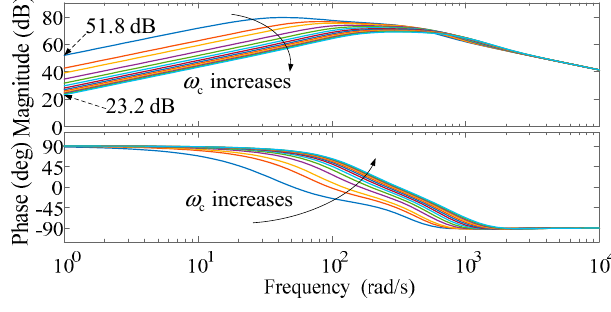
( s ) with changing ω c (di ff erent colors represent di ff erent gains; the same ( ) M s Q ( s ) ( ) Q s with changing c ( ) M s ( ) Q s with changing c